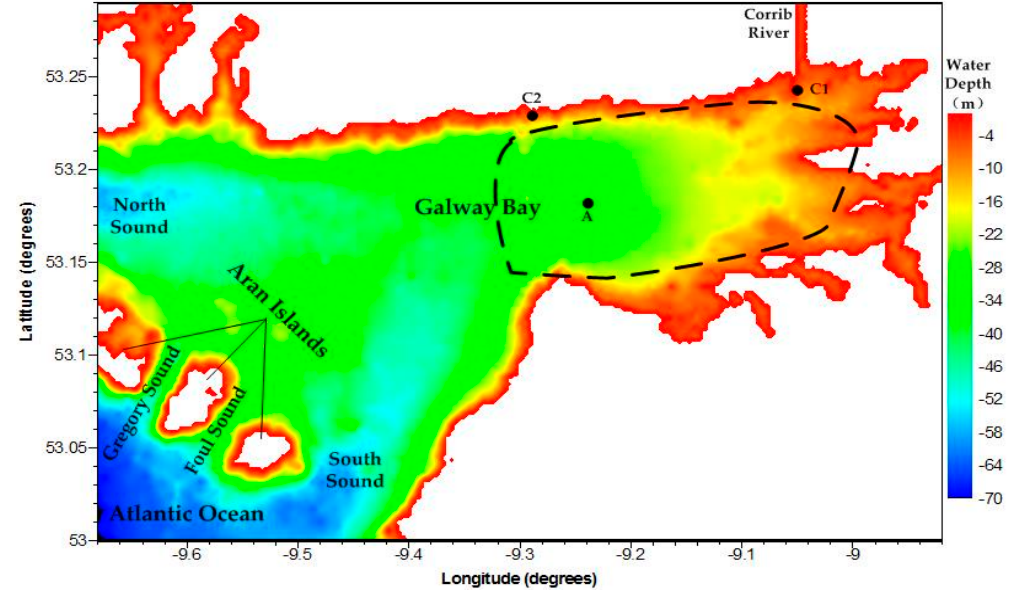
Figure 1. Radar stations in Galway Bay (C1 and C2 indicate the deployment location of radar at Mutton Island and Spiddal Pier, respectively; A indicates an analysis point; and dashed area indicates main coverage area of HFR system).